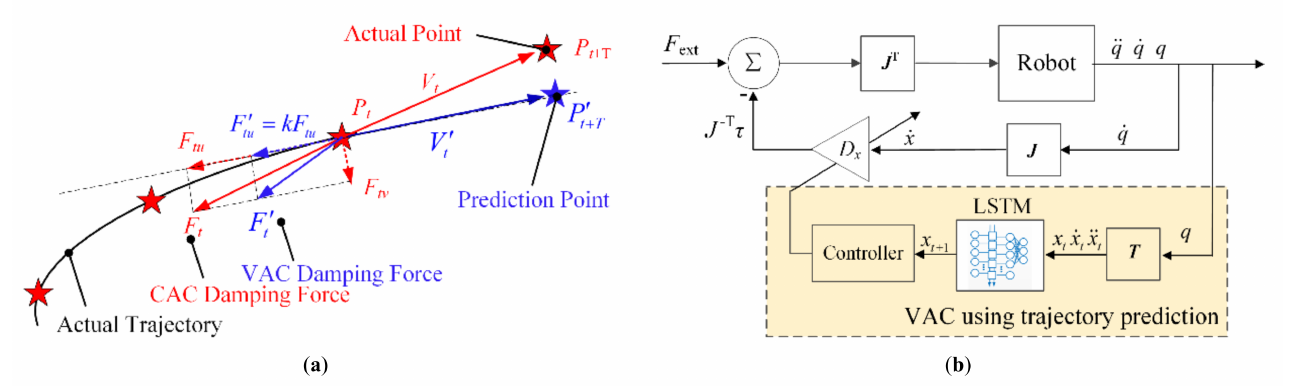
Figure 2. ( a ) Schematic diagram of TPVAC. ( b ) Control block diagram of TPVAC. In Figure 2a, points P t and P t + ∆ t are the positions of the robot end tool at time t and t + ∆ t , respectively, and P ’ t + ∆ t is the predicted point at time t + ∆ t . V t and V ’ t are actual P t )/ ∆ t . Then the predicted motion direction vector is d mt = V ’ t /| V ’ t |. F t and F ’ t are